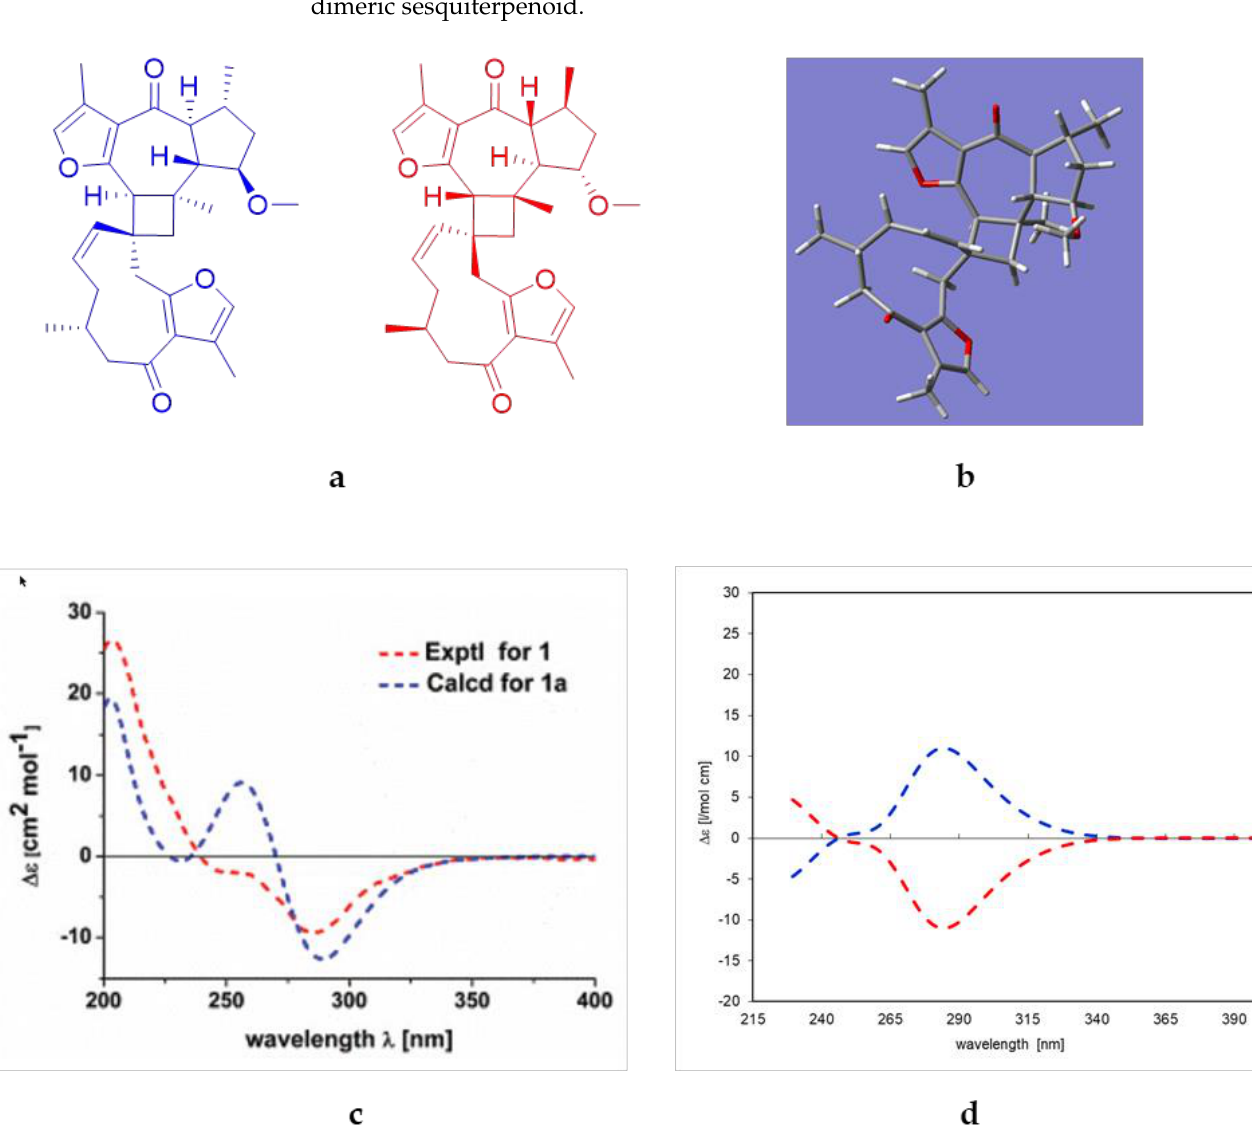
Figure 7. ( a ) Blue: Structure of commiphorine A according to [21], red: Enantiomeric structure; ( b ) minimum energy conformer of the blue structure depicted in ( a ) after a conformational search and full energy minimization (MMFF94x force field/low mode dynamics/energy minimization by MOPAC/PM3 followed by DFT B3LYP/6 − 31G(d,p)). ( c ) Experimental ECD spectrum of commiphorine A (red curve) and simulated ECD spectrum (blue curve) according to [21]. ( d ) Blue: ECD spectrum simulated by TDDFT (B3LYP/6 − 31G(d,p)) in the present study with the postulated [21] structure of commiphorine A (blue structure in a ). Red: Simulated ECD spectrum of the enantiomer of the pos- tulated [21] structure (red structure in a ). Note the very close fit of the red curve with the experi- mental spectrum shown in c .